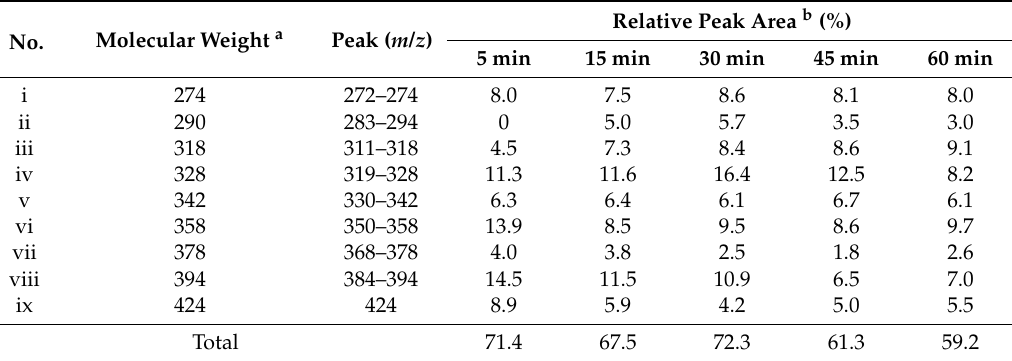
Table 1. Distribution of the aromatic oligomers identified by Matrix-assisted laser desorption/ionization time-of-flight mass spectrometry (MALDI-TOF MS) from lignin degradation at different reaction times under 160 ◦ C.